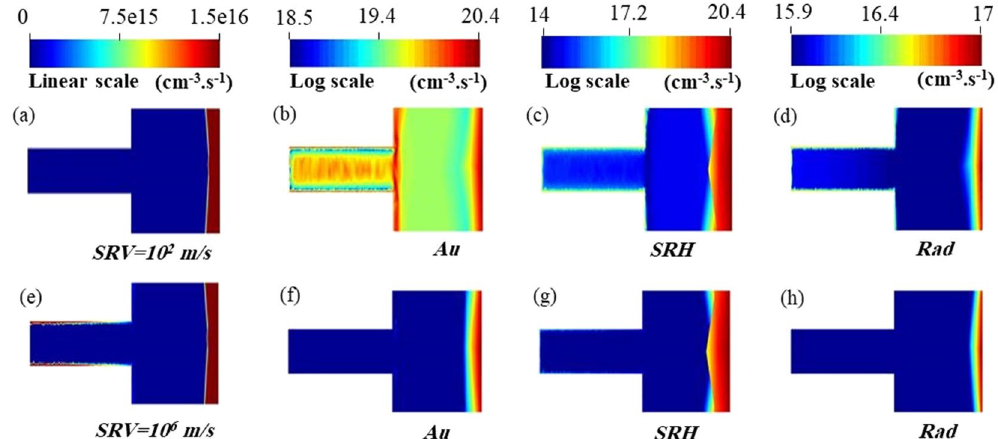
Figure 17. Recombination rate of the ( a )/( e ) surface, the ( b )/( f ) Au, the ( c )/( g ) SRH, and the ( d )/( h ) radiative for the proposed NW design in core–shell junction at good ( 10 2 m/s)/bad ( 10 6 m/s) surface passivation. This image is created by Lumerical 2020a, FDTD Solver Version 8.23.2305, https:// www. lumer ical. com (license number-12802) released to Zewail City of Science and Technology, Giza,